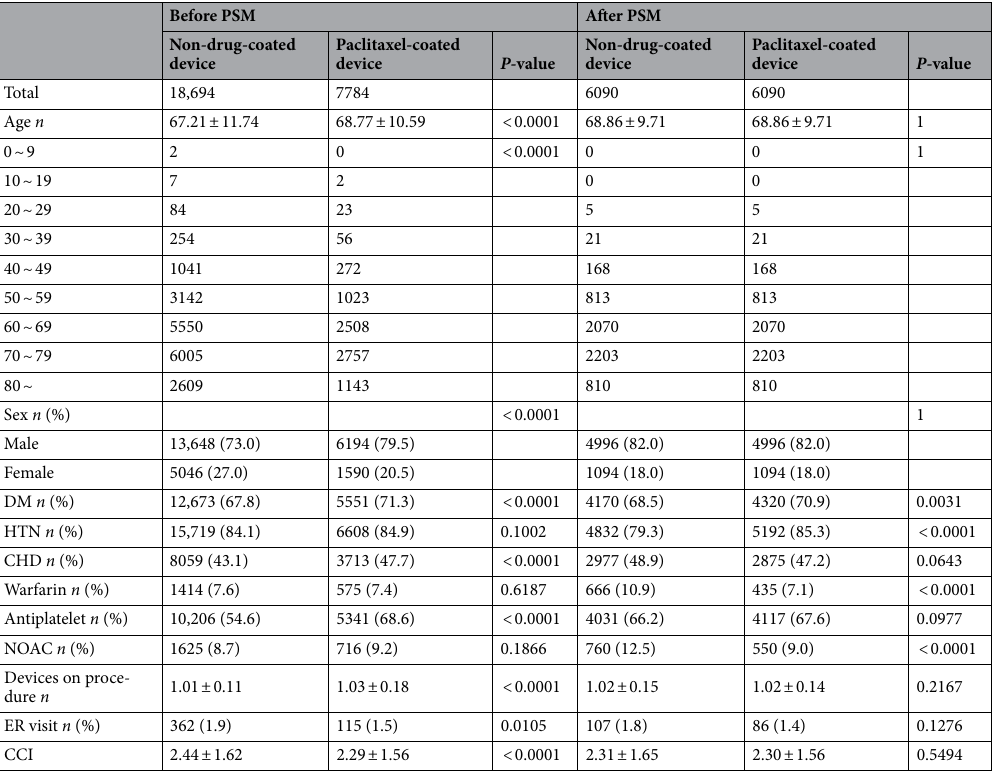
Table 1. Baseline characteristics of study population. Values are expressed as mean ± standard deviation (SD), or n (%). DM diabetes mellitus, HTN hypertension, CHD coronary heart disease, NOAC new oral anticoagulants, CCI Charlson comorbidity index, ER emergency